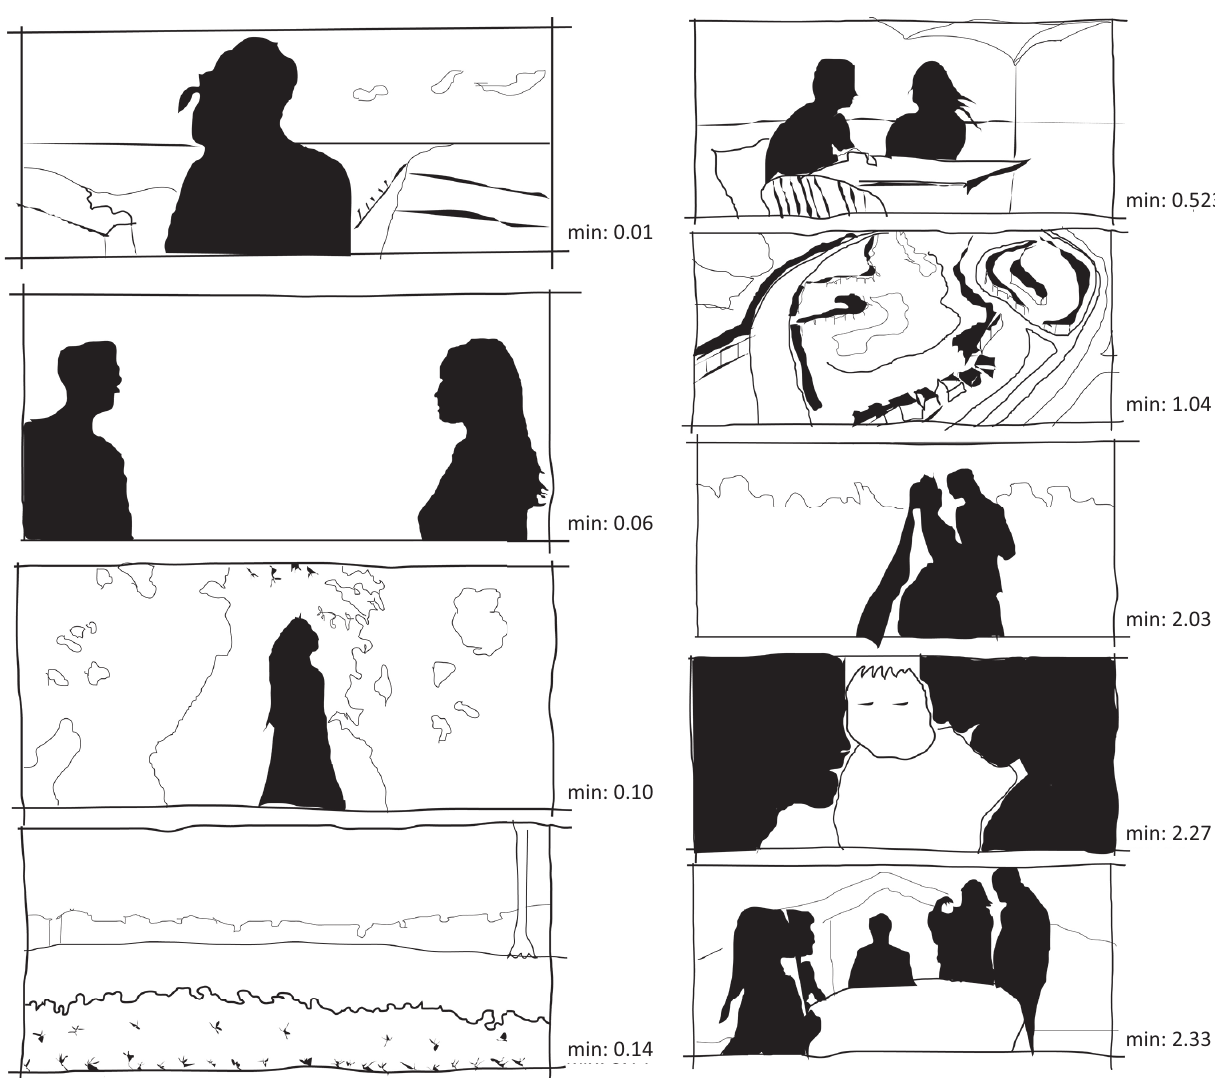
Figure 4. Abstracted screenshots from Madinaty advertisement in order from top to bottom. Source: Hendawy’s drawing based on Madinaty advertisement from Sada el Balad